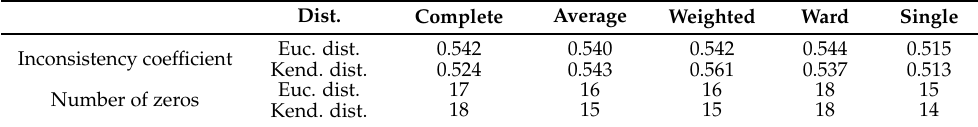
Table 1. Mean of inconsistency coefficient of the hierarchical cluster tree.